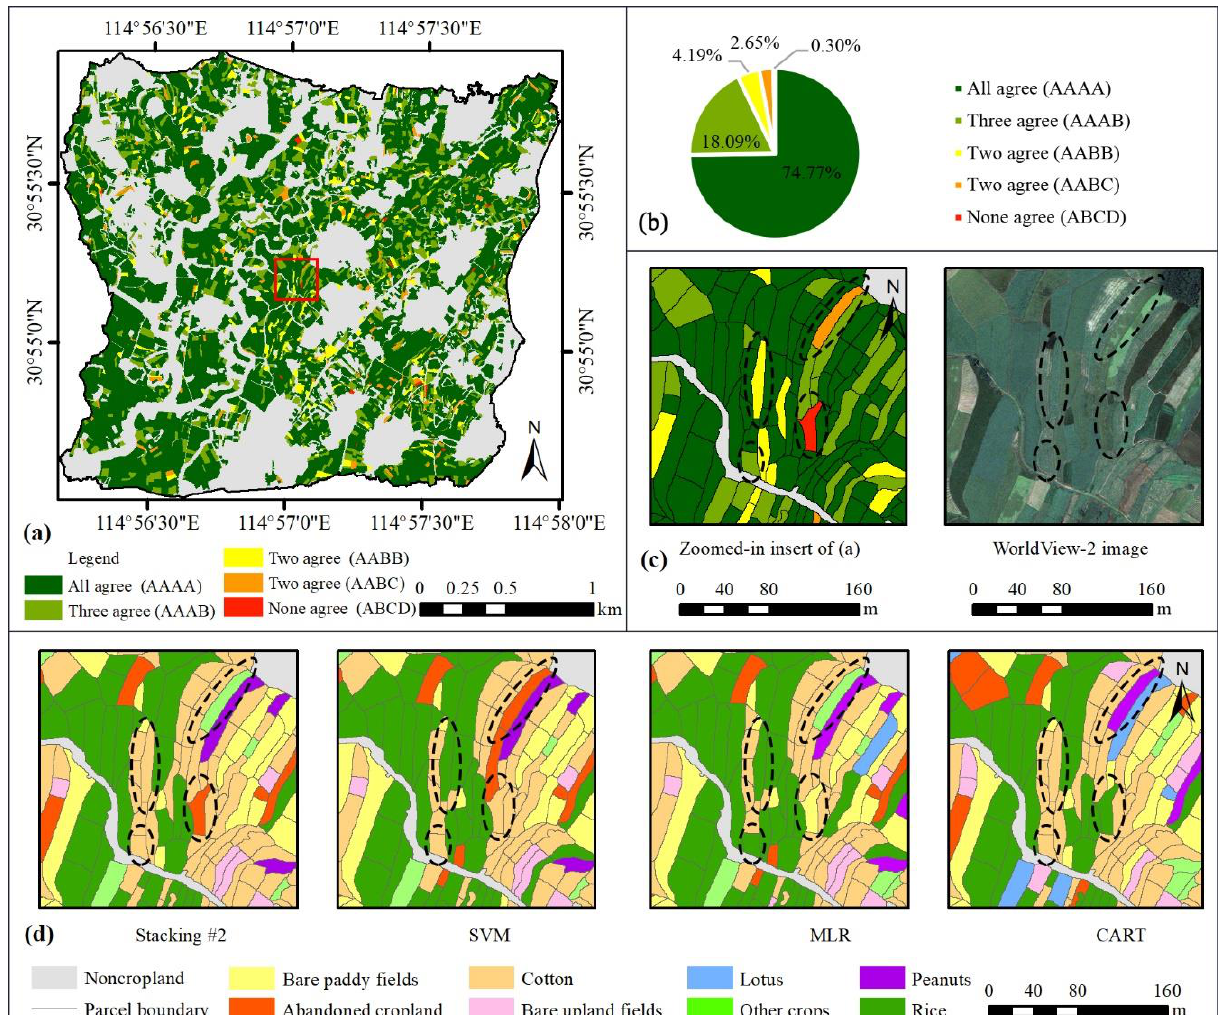
Figure 7. Map showing the positions where the four classifiers (Stacking #2, SVM, MLR, and CART) agree and disagree in predicting the crop types ( a ). Proportions of the five agreement types ( b ). Partially enlarged agreement map ( c , left), the corresponding image object ( c , right), and the corresponding crop type map ( d ).